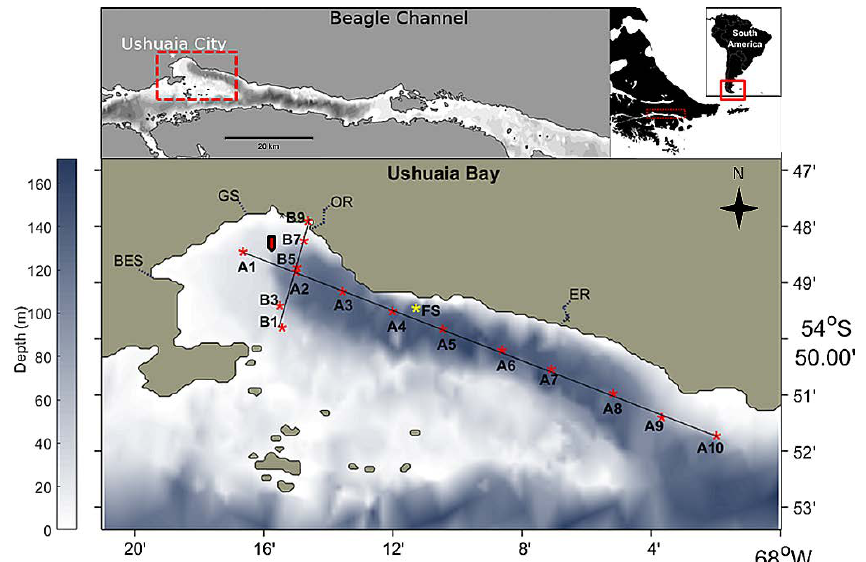
Figure 1. Map of the study area located in Tierra del Fuego, South America (upper right panel), as a branching of the Beagle Channel (upper left panel). Bathymetry in the Ushuaia Bay and its valley (lower panel) is in a grey-white color gradient. Cross-Bay section (B1–B9 stations) from 54°50.088’ S–68°15.710’ W to the 54°47.992’ S–68°14.781’ W, linking the western peninsula with the river mouth of the Rio Olivia, Along Bay section (A1–A10 stations) from 54°48.500’ S–68°16.800’ W to 54°49.595’ S–68°12.183’ W and Fixed Station (FS in yellow) are represented. The freshwater inputs are indicated: BES (Buena Esperanza stream), GS (Grande Stream), OR (Olivia River) and ER (Escondido River).